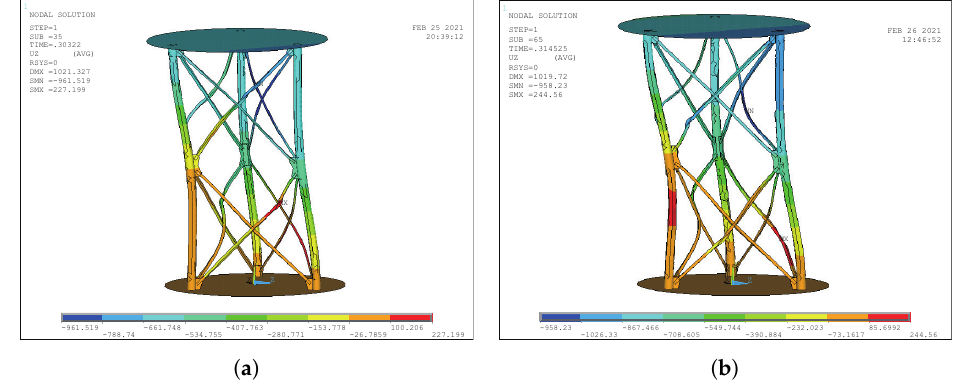
Figure 13. ( a ) The maximum displacement in horizontal Z direction of triangular tower with the SLSPJ. ( b ) The maximum displacement in horizontal Z direction of triangular tower with the DLDPJ.